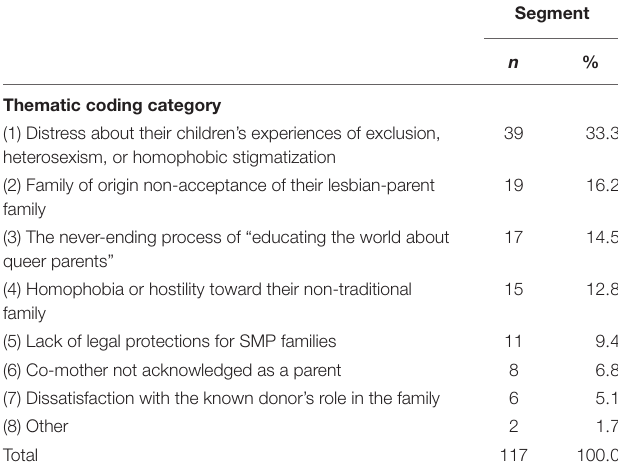
TABLE 1 | Demographic information for the sample. TABLE 2 | Most challenging parenting